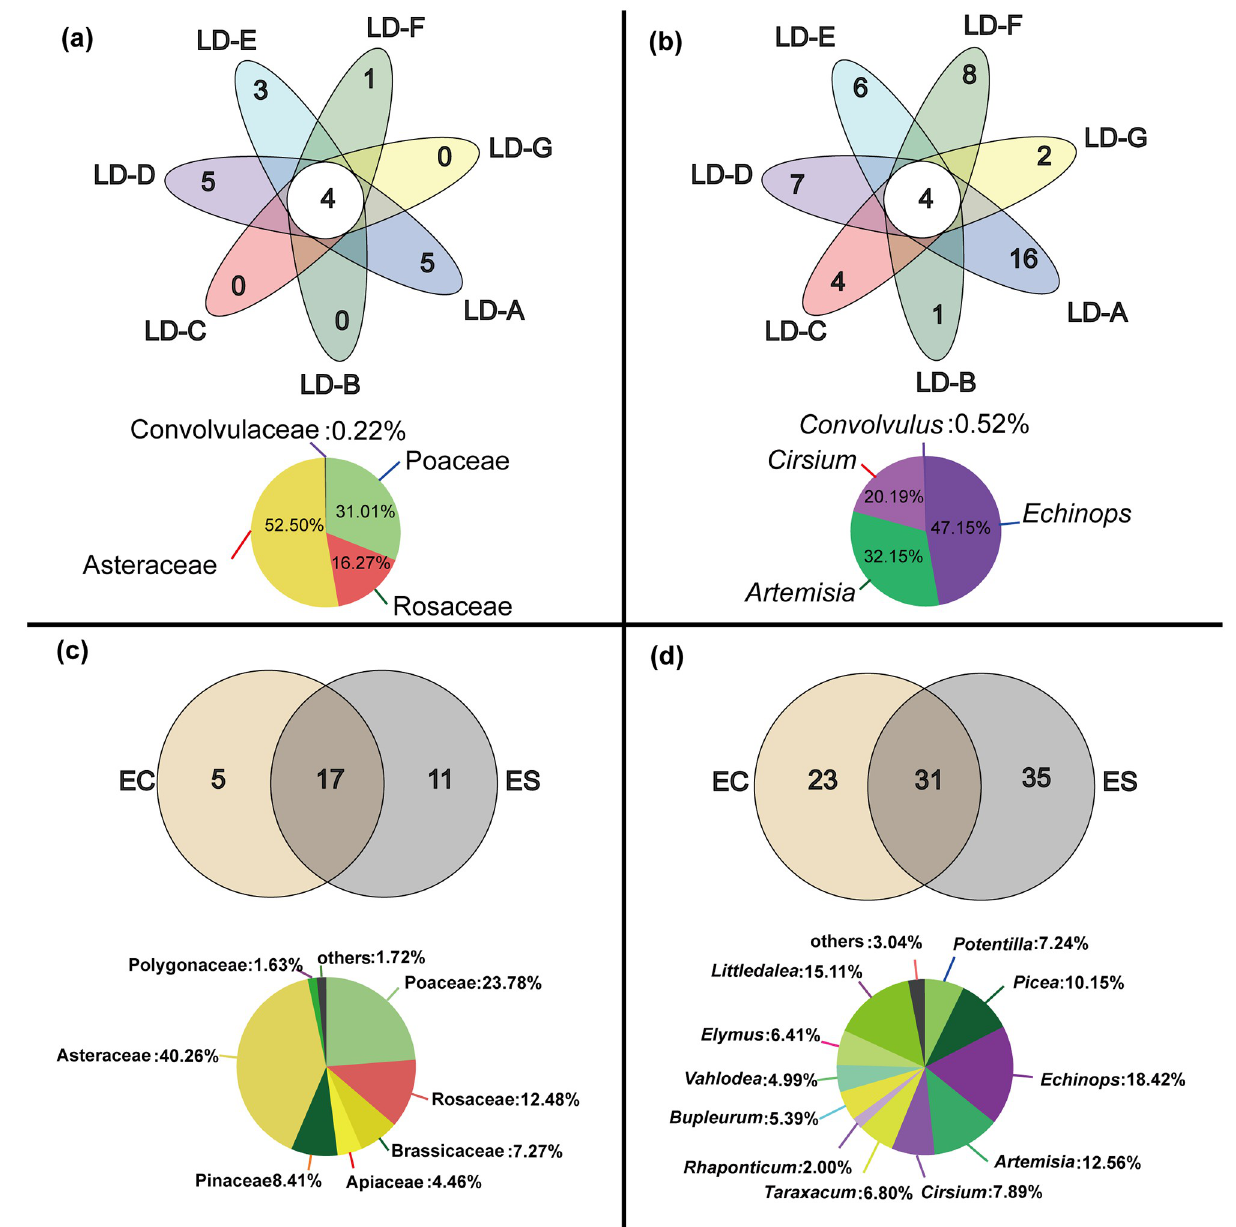
Fig 2. Venn diagram of zokor diet. a and b show the food species of the zokor at the family and genus level in the seven study areas respectively. The pie charts below show the food species of the zokor in all the study areas. c and d show the food species of the zokor at the family and genus level both species of zokors, respectively. The pie charts below shows the families and genera that both zokor species choose to feed